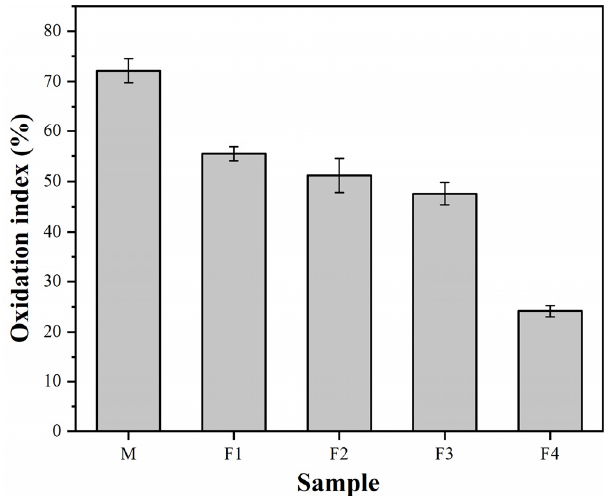
Figure 3. Oxidation index of the castable specimens after heat treatment at 1450 °C for 3 h.